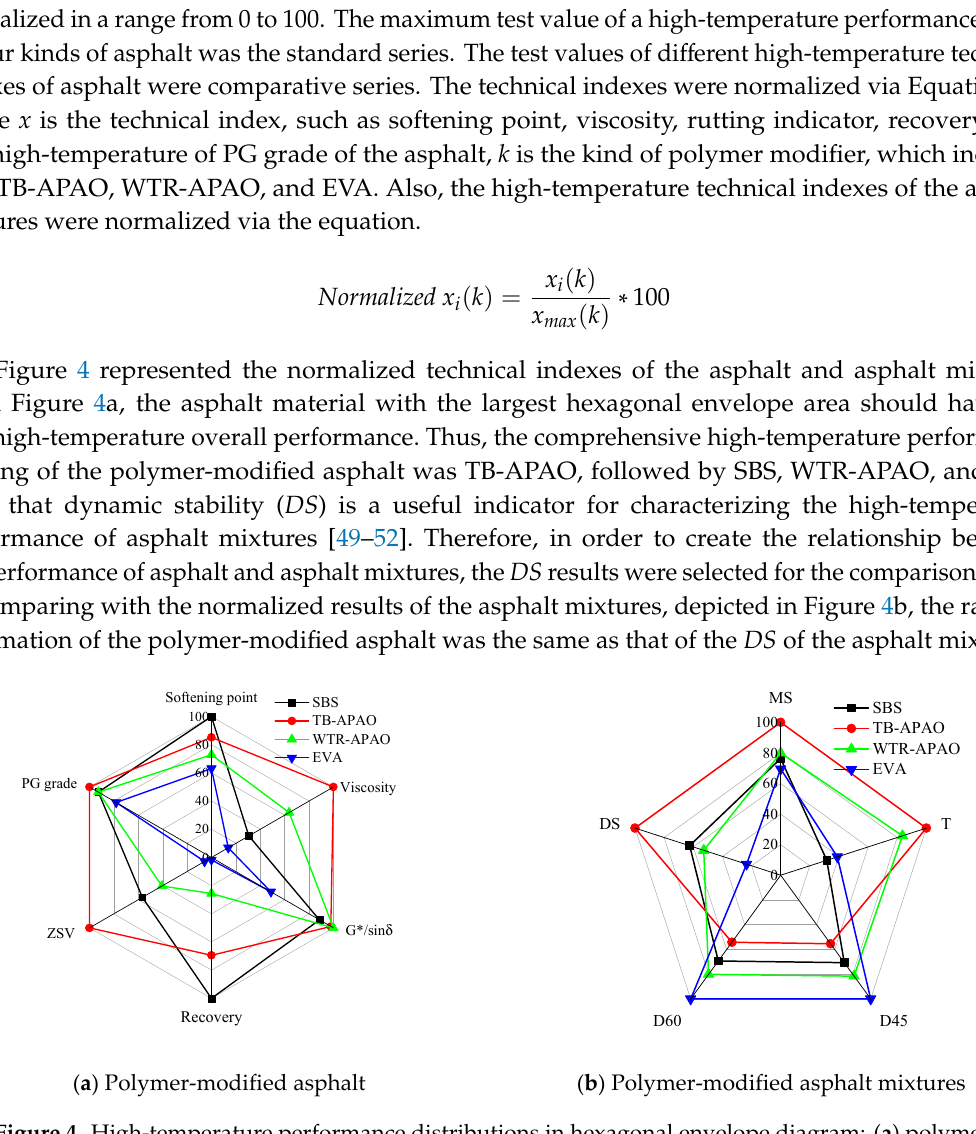
Figure 4. High-temperature performance distributions in hexagonal envelope diagram: ( a ) polymer- modified asphalt and ( b ) polymer-modified asphalt mixtures.